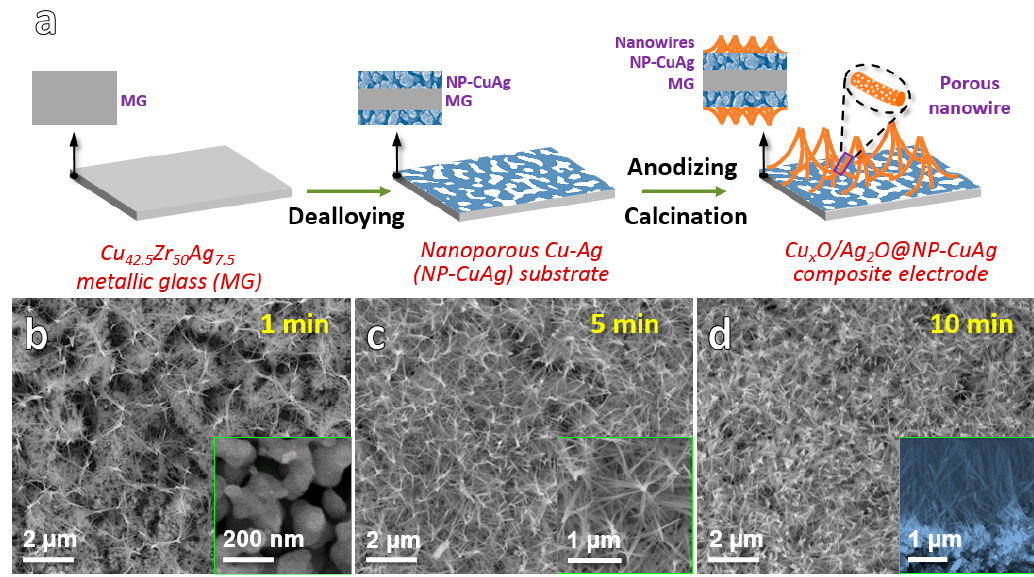
Figure 1. ( a ) Schematic illustration showing the synthesis process of Cu x O/Ag 2 O@NP-CuAg composite; SEM images of Cu x O/Ag 2 O@NP-CuAg anodized for different time followed by calcination ( b ) 1 min with the inset of NP-CuAg substrate; ( c ) 5 min and the magnification image; ( d ) 10 min with the sectional image.